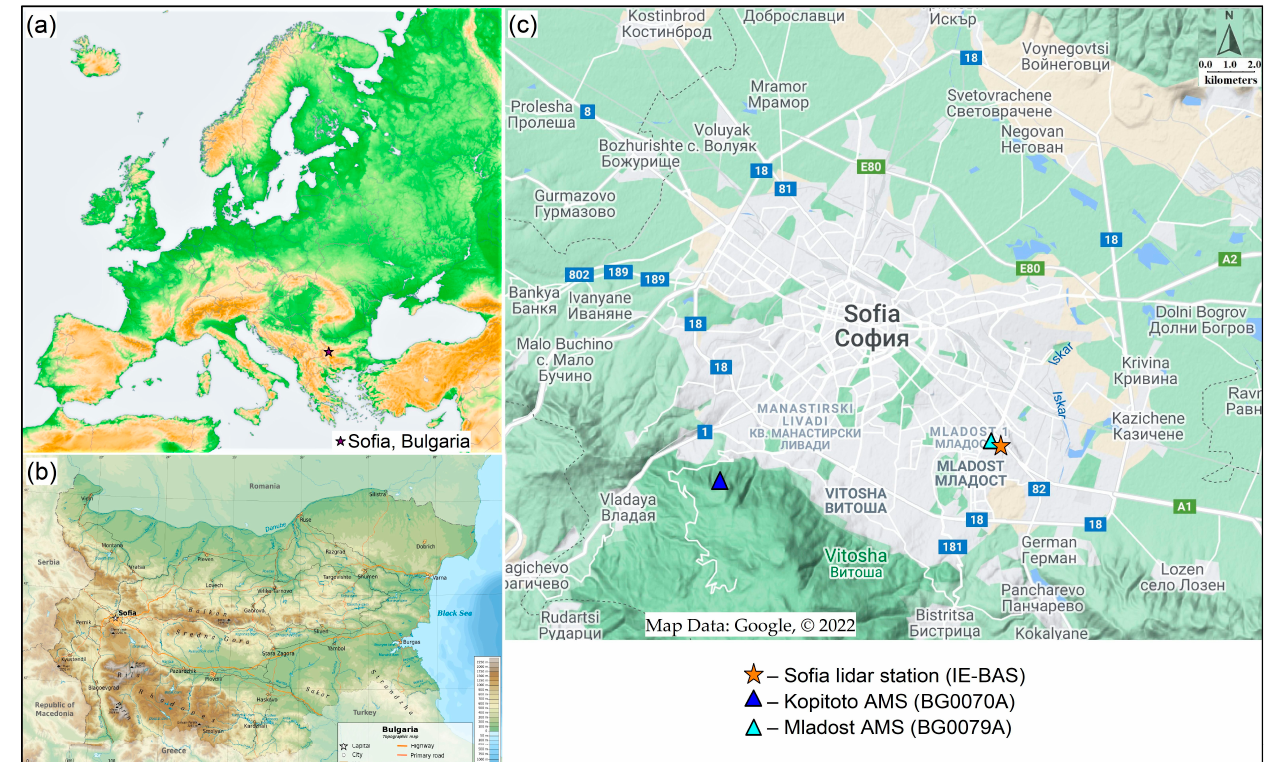
Figure 1. Geographical situation of the area of measurements: topographic maps of ( a ) Europe (source: https://commons.wikimedia.org/wiki/File:Europe_topography_map_en.png, accessed on 1 February 2022), ( b ) Bulgaria (source: https://commons.wikimedia.org/wiki/File:Bulgaria-geographic_map-en.svg, accessed on 1 February 2022), and ( c ) Sofia (Google maps image). The positions are indicated of Sofia, the lidar station, and the Kopitoto AMS and Mladost AMS.